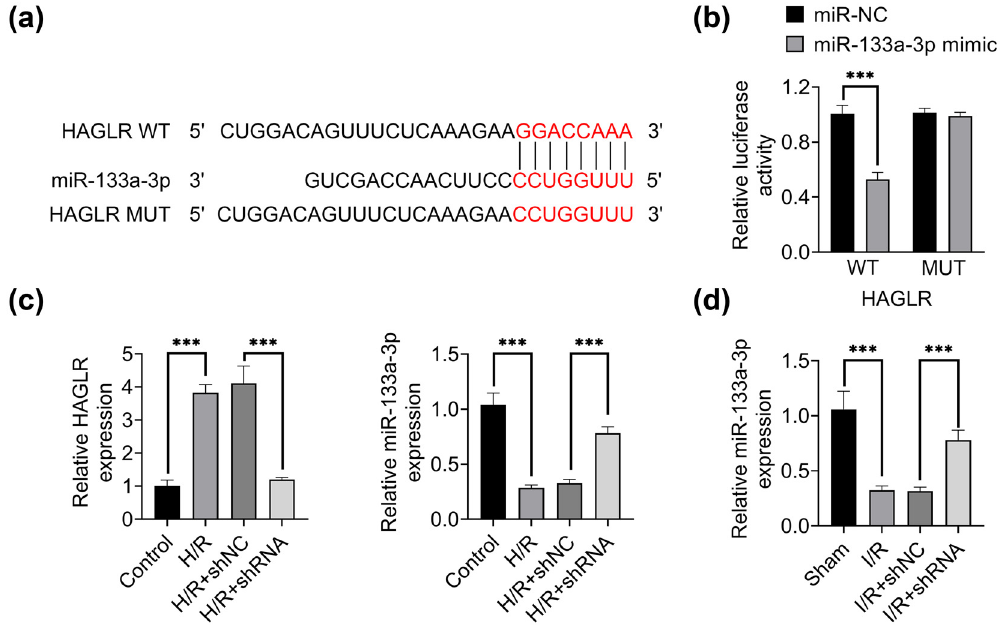
Figure 3: HAGLR targeted and regulated the expression of miR - 133a - 3p. ( a ) The binding site of HAGLR to miR - 133a - 3p was predicted based on the LncBase database. ( b ) Luciferase reporting system was used to detect the relative luciferase activity in HAGLR wild type ( WT ) and mutant ( MUT ) transfected with miR - NC or miR - 133a - 3p mimic. *** p < 0.001. Data were expressed as mean ± SD of three independent experiments.